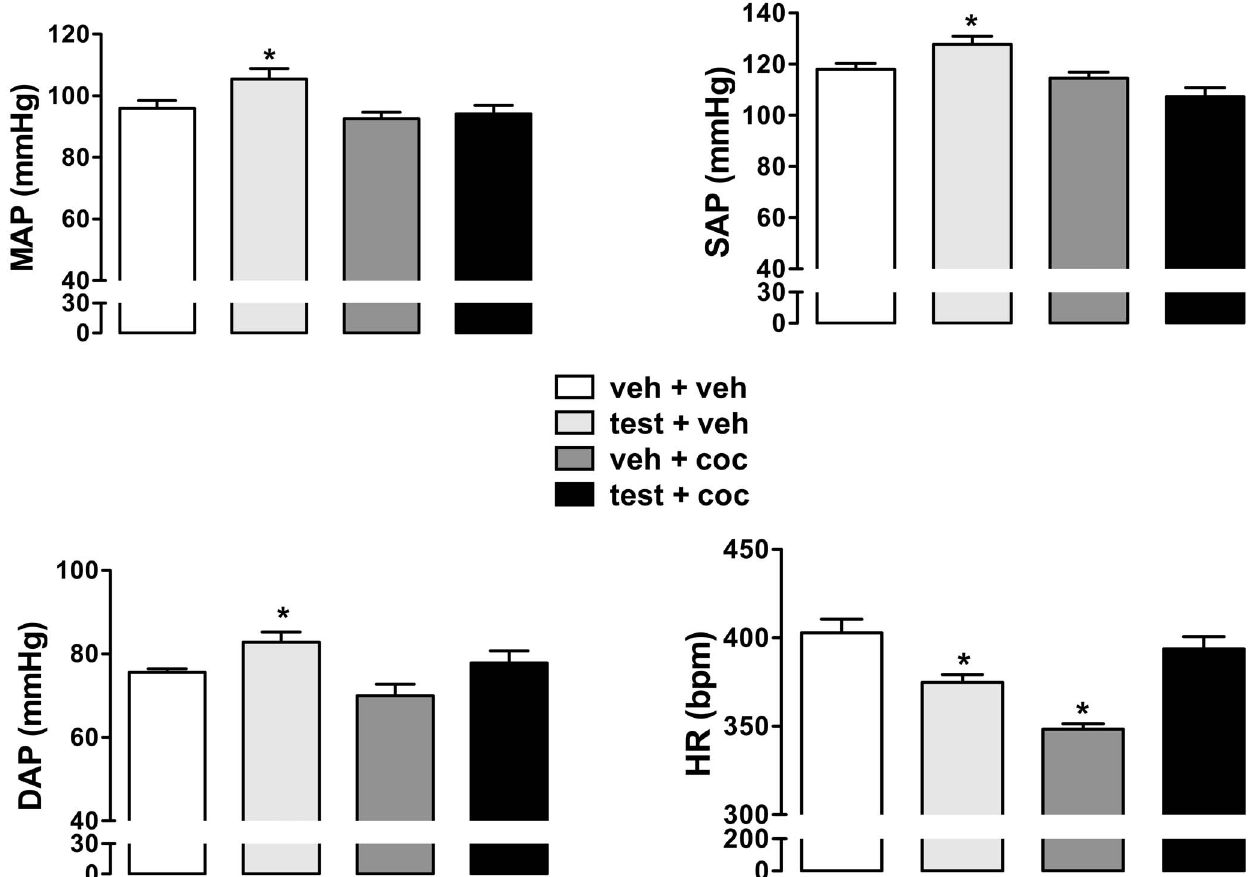
Figure 1. Mean arterial pressure (MAP), systolic arterial pressure (SAP), diastolic arterial pressure (DAP) and heart rate (HR) in adolescent animals subjected to treatment for 10 consecutive days with testosterone and cocaine alone and in combination. The bars represent the mean 6 SEM. veh – vehicle, test - testosterone and coc - cocaine. * P , 0.05 vs veh + veh group, one-way ANOVA followed by Bonferroni’s post hoc test.